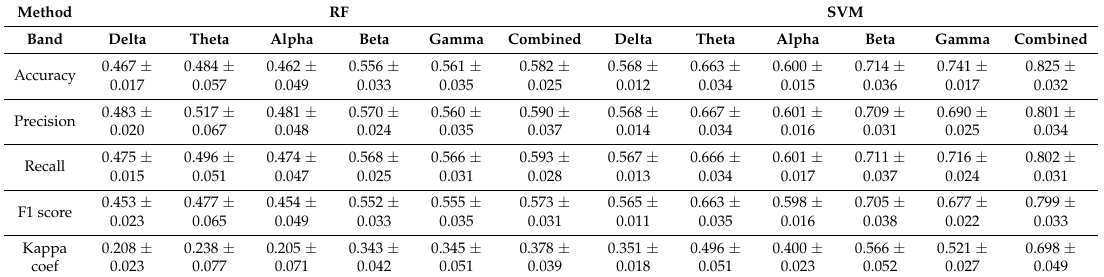
Table 4. Predictive performance with five methods using the differential entropy dataset and